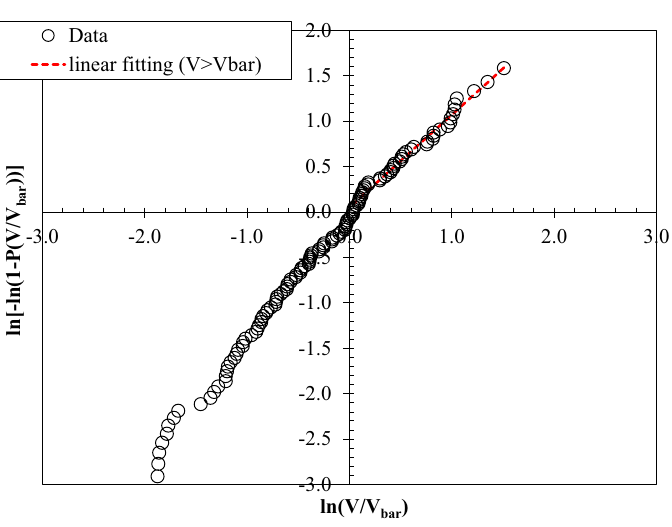
Figure 2. Weibull plot of overtopping volumes for an experiment representing a typical low wave steepness condition, s 0p = 1.8% with a significant wave height of 0.07